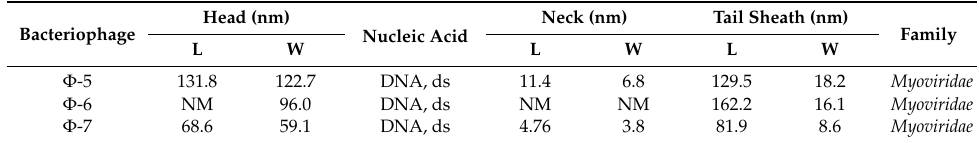
Table 2. Characteristics of the Vibrio bacteriophages isolated in this